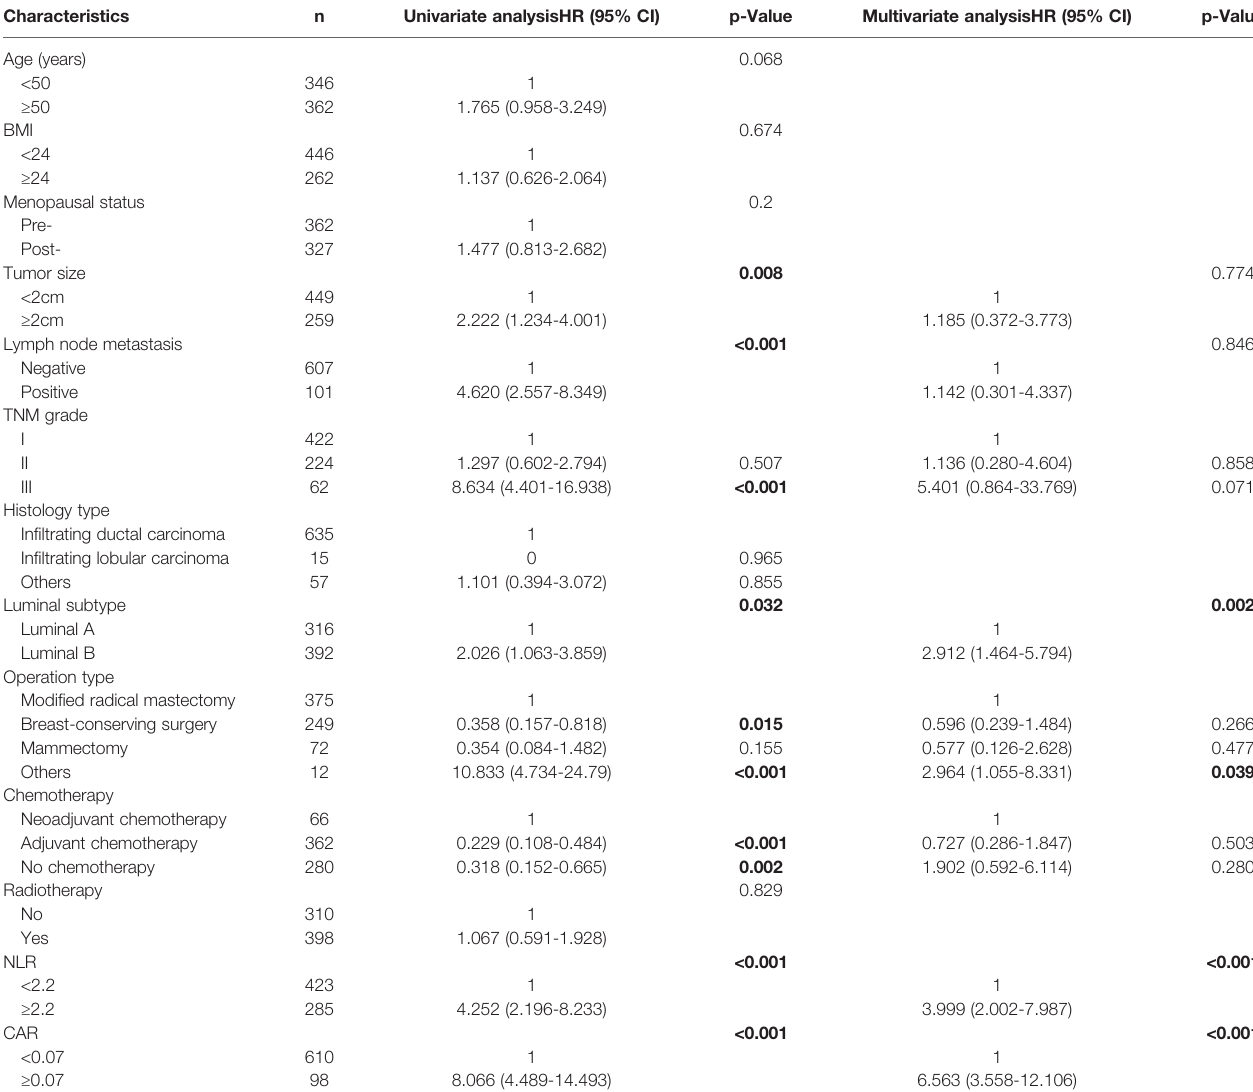
TABLE 5 | Univariable and multivariable analyses of CSS in Luminal BC with HER2-negativity.